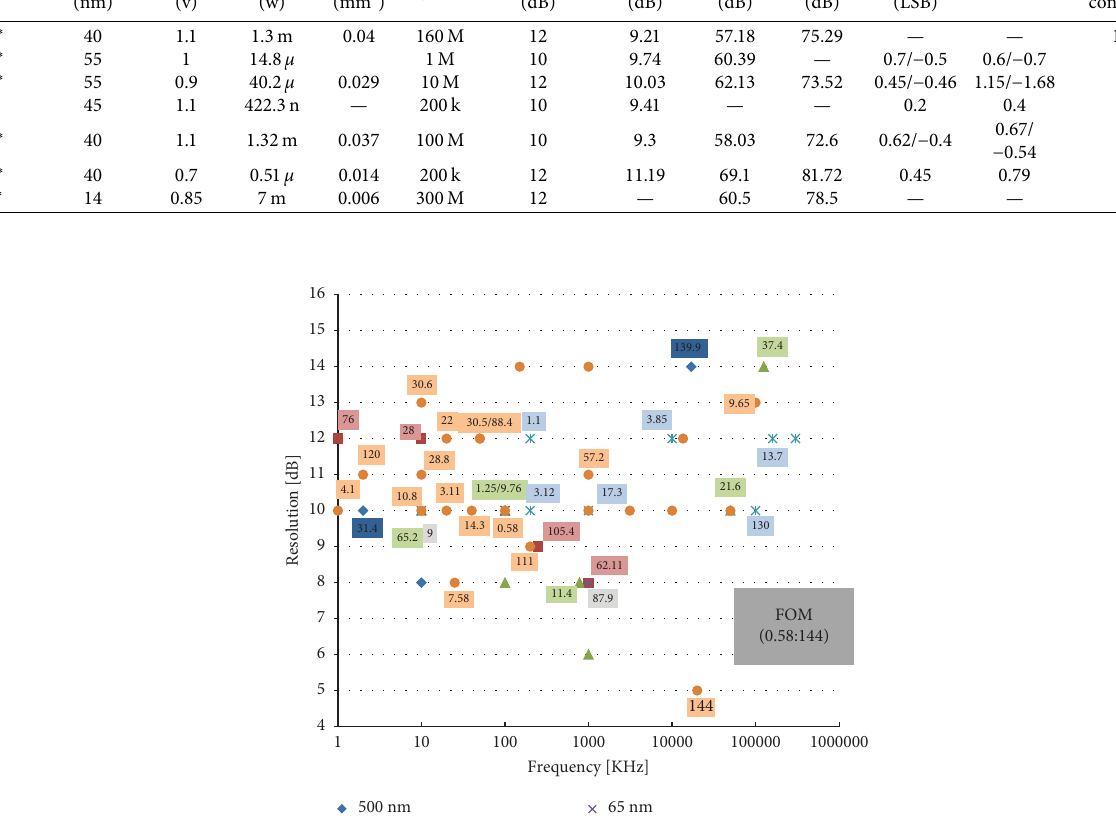
Table 8: Summary of the recently published SAR ADC performance parameters in less than 65nm process.